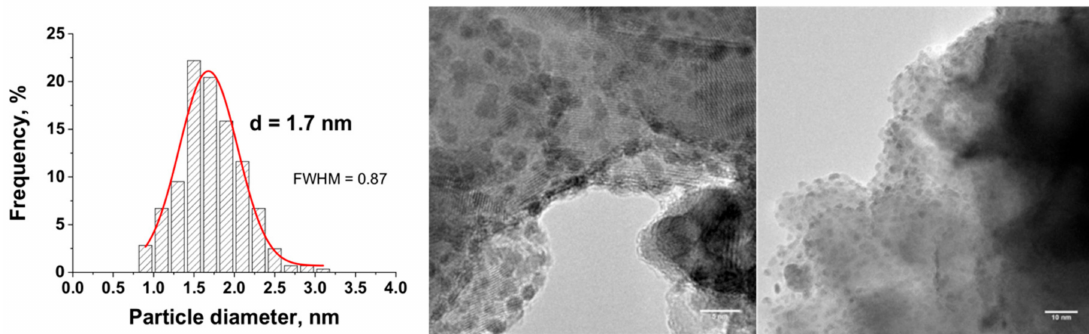
Figure 10. TEM images with the derived histograms of the Ru nanoparticle size distribution for the Ru(5 wt.%)/TiO 2 -P25 catalyst obtained by the photon-assisted preparation method, after treatment at 200 ◦ C under hydrogen for 2